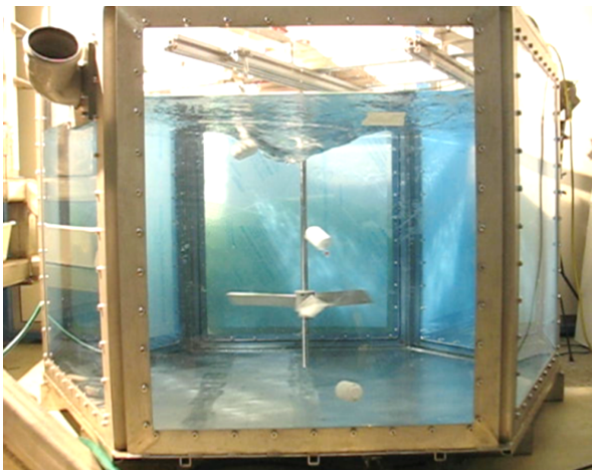
Figure 3. Characterization of the required density offset of sensor particles in a stirred vessel experiment in water for an improved recovery at the liquid